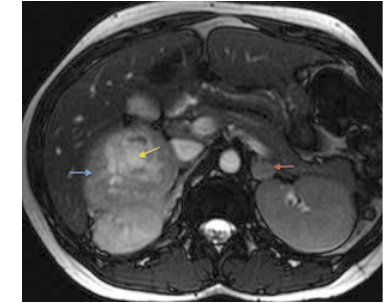
Fig. 6. Familial phaeochromocytomas in a 23-year-old woman. Axial T2-weighted image demonstrating bilateral phaeochromocytomas. A large heterogeneous right adrenal mass (blue arrow) with central necrosis (yellow arrow) and a smaller, well-defined, homogenous left Fig. 7. Benign phaeochromocytoma in a 57-year-old woman. (A) Contrast-enhanced CT scan demonstrates adrenal mass (red arrow) are shown. a well-encapsulated heterogeneous left adrenal mass representing a phaeochromocytoma (blue arrow) with peripheral enhancement (red arrow) and a central area of low attenuation owing to necrosis (yellow arrow). K = displaced left kidney. F = incidental uterine fibroid. (B) MIBG image shows accumulation of radiotracer in the left phaeochromocytoma (blue arrow). Photopenic area (red arrow) is consistent with